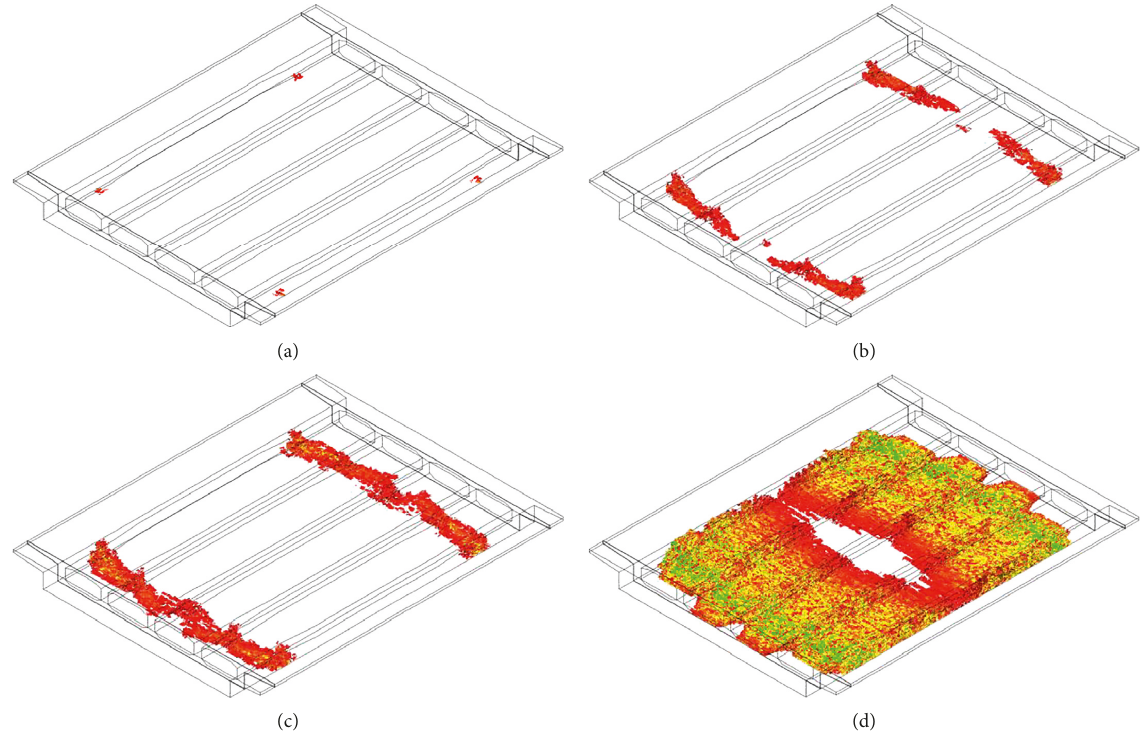
Figure 16: Crack distribution of girder. (a) Load value: 14841kN. (b) Load value: 15423kN. (c) Load value: 15714kN. (d) Load value: